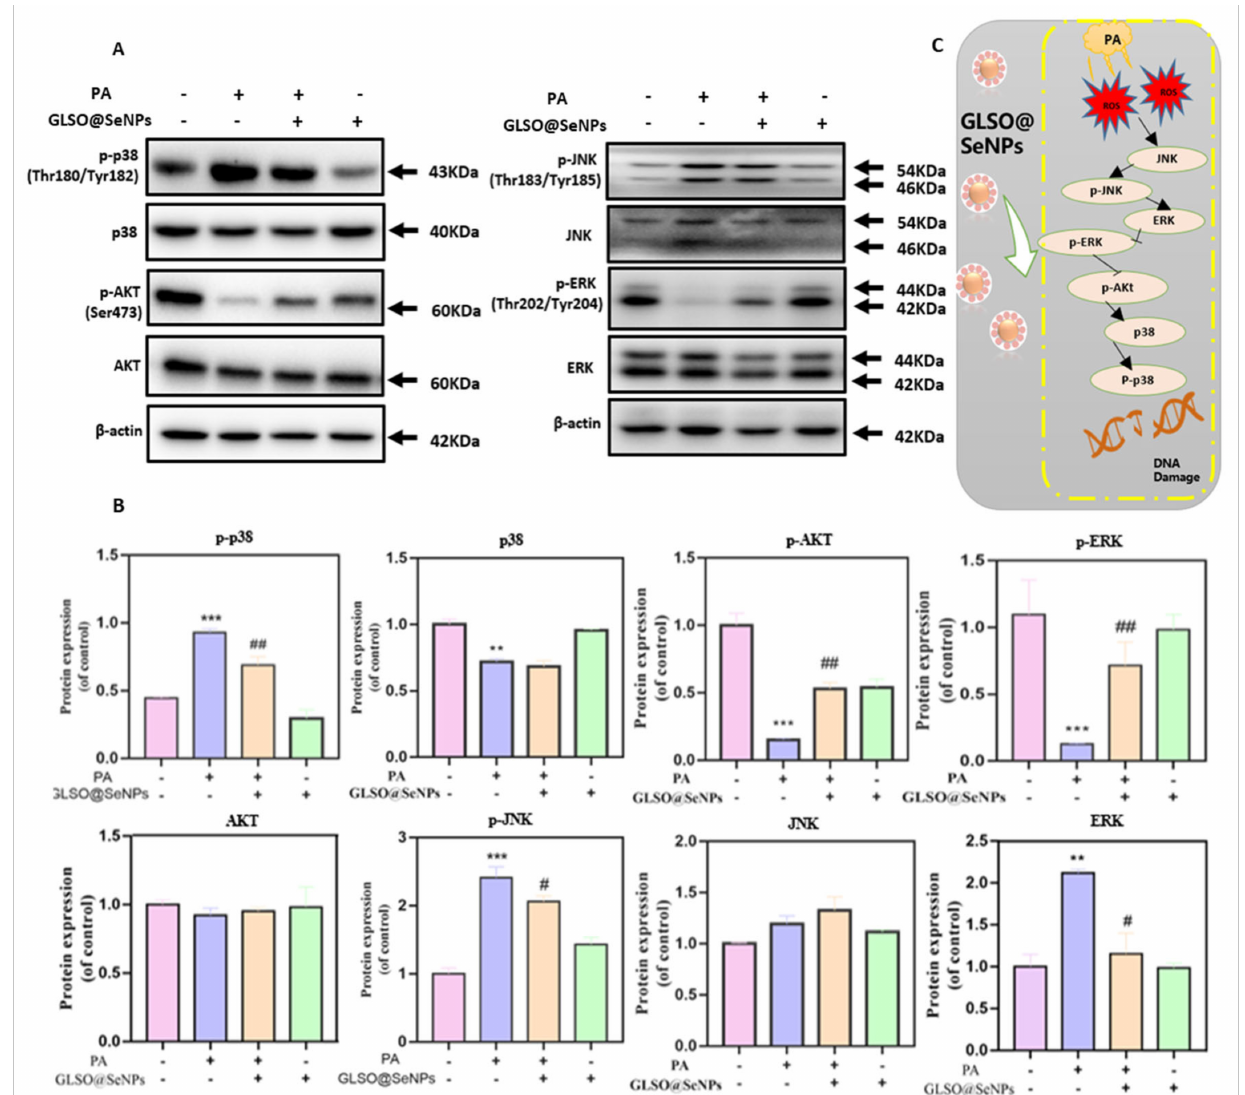
Figure 8. GLSO@SeNPs inhibit PA-induced apoptosis by regulating the MAPK signaling pathway in INS-1E cells. ( A ) Protein expression levels of p-p38, p38, p-AKT AKT, p-JNK, JNK, p-ERK, and ERK. ( B ) Quantitative analysis of protein bands. (Firstly, the grayscale of the target strip was divided by the grayscale of the corresponding β -actin reference strip, and then the mean value of the control group was calculated. Finally, each group was divided by the mean value of the control group. The resulting values are used to make bar charts.) (# p < 0.05 means the lowest significance, ** (##) p < 0.01 means moderate significance, *** p < 0.001 means high significance). ( C ) Schematic diagram of the MAPK signaling protein